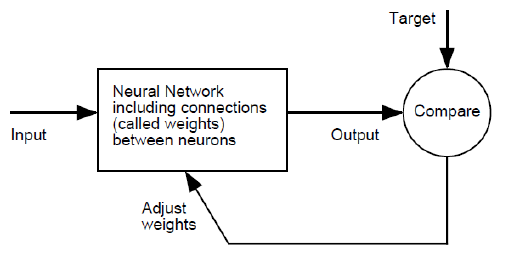
Figure 1. Artificial neuron model.